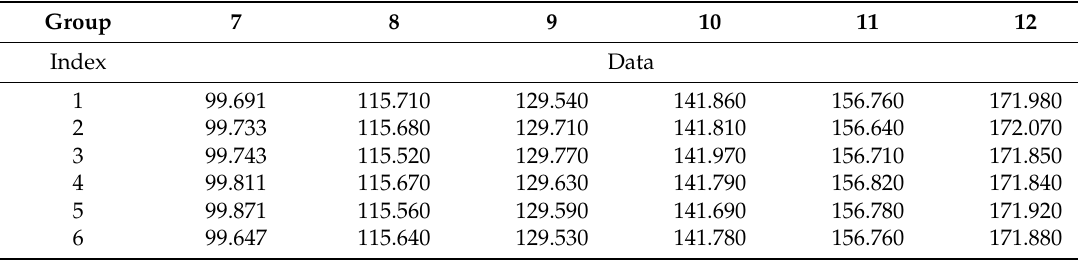
Table 3. Data and statistics of precision test Groups